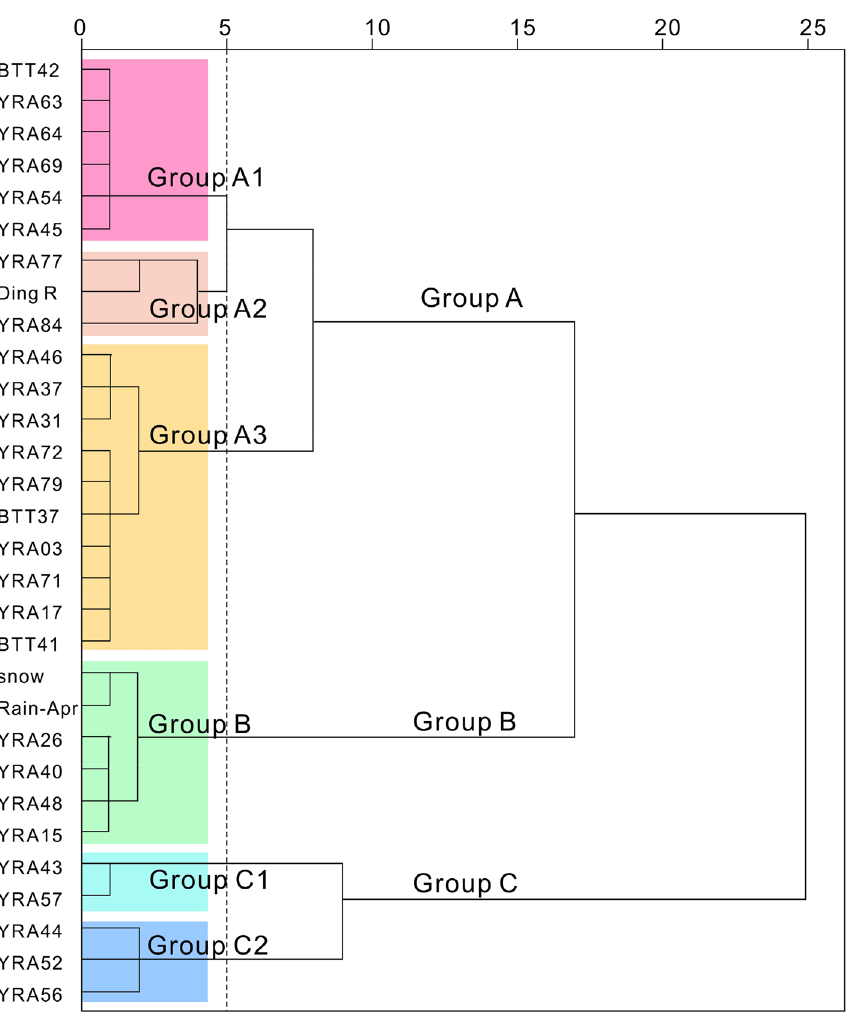
Figure 11. Dendrogram of the hierarchical cluster analaysis showing the identified groups and subgroups.